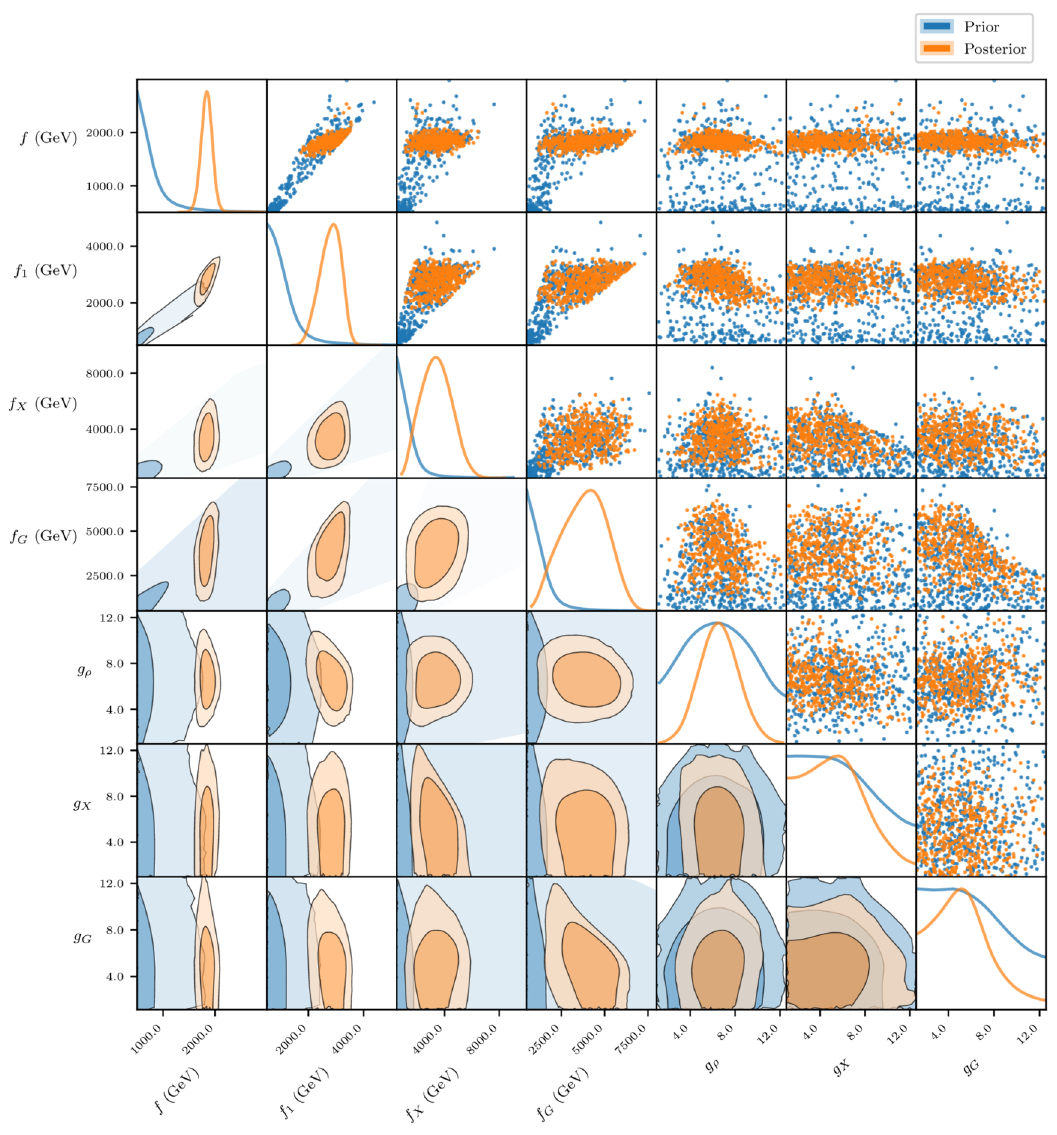
Figure 6. 1D and 2D marginalised priors and posteriors for the gauge sector parameters in the M4DCHM 14 − 14 − 10